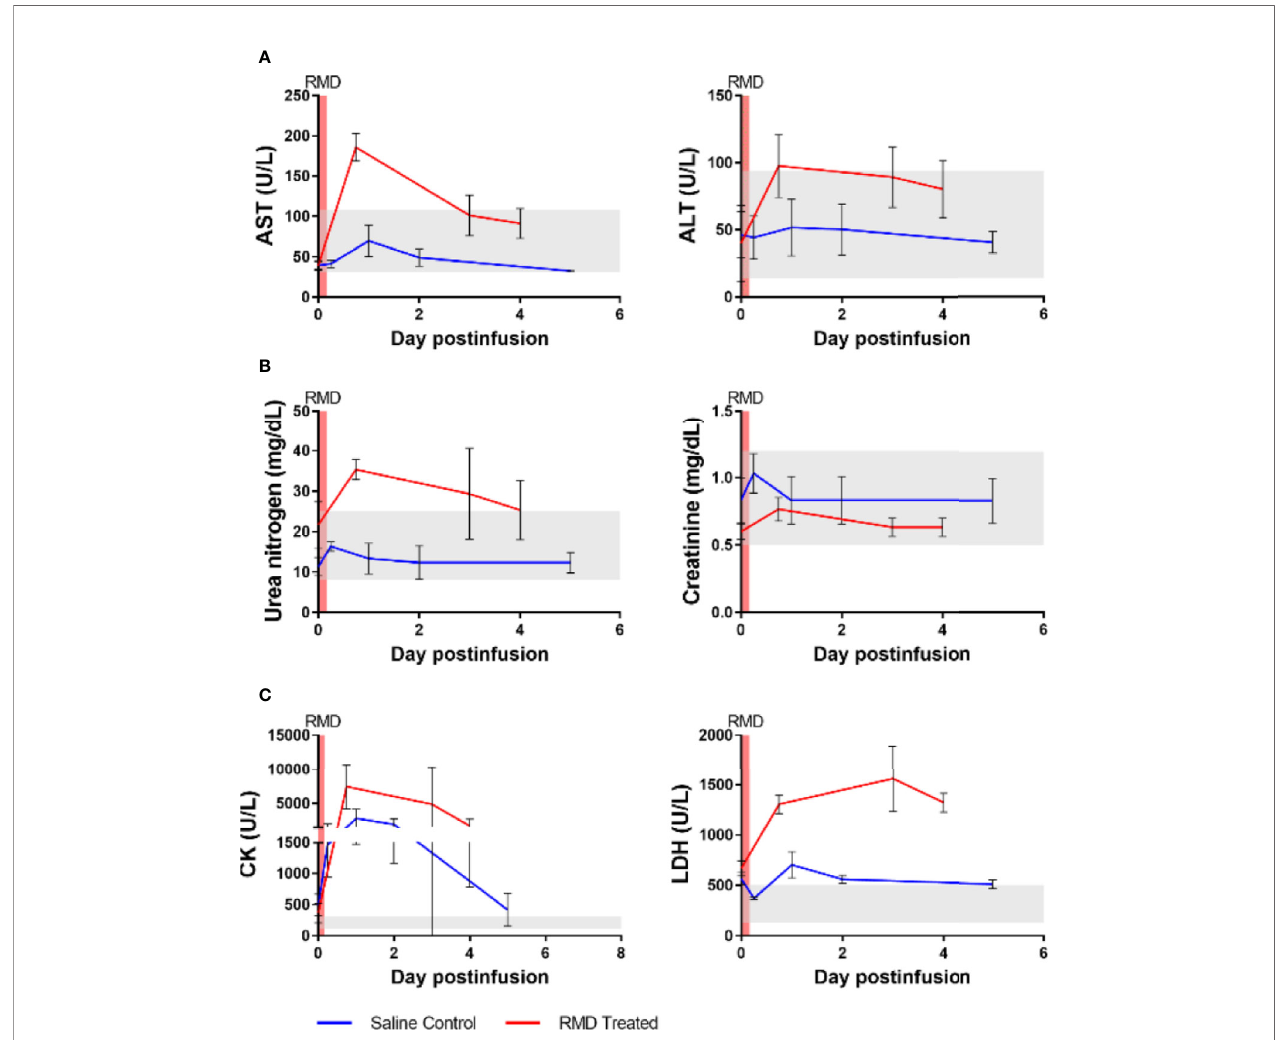
FIGURE 4 | Blood chemistries of markers for hepato- and nephrotoxicity and general markers of cell death of three SIV-naïve rhesus macaques after second round of RMD. (A) Hepatotoxicity markers, aspartate aminotransferase (AST) and alanine transaminase (ALT). (B) Nephrotoxicity markers, urea nitrogen and creatinine. (C) General markers of cell death, creatinine kinase (CK) and lactate dehydrogenase (LDH). The grey area represents the average reference values for the markers in three SIV-naïve, untreated